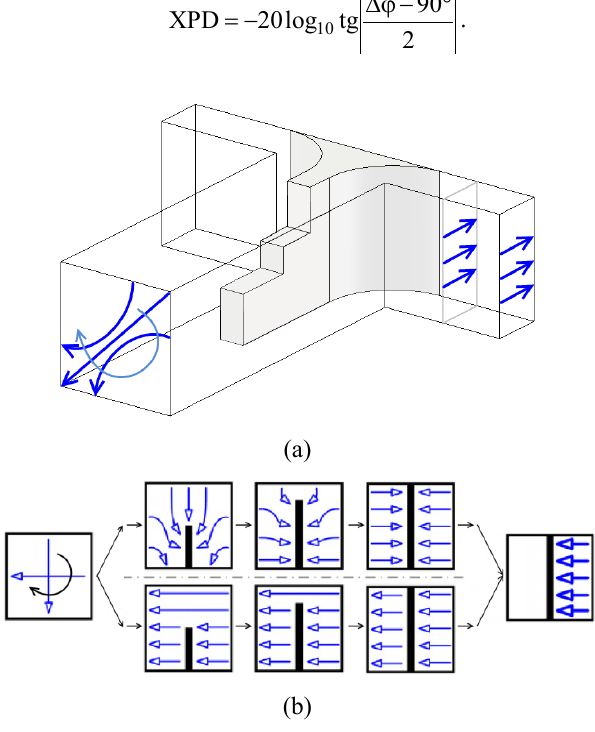
FIGURE 2. Propagation of RHCP mode in a septulum polarization converter: (a) propagation from port to port; (b) representation of the transmission as a superposition of orthogonal